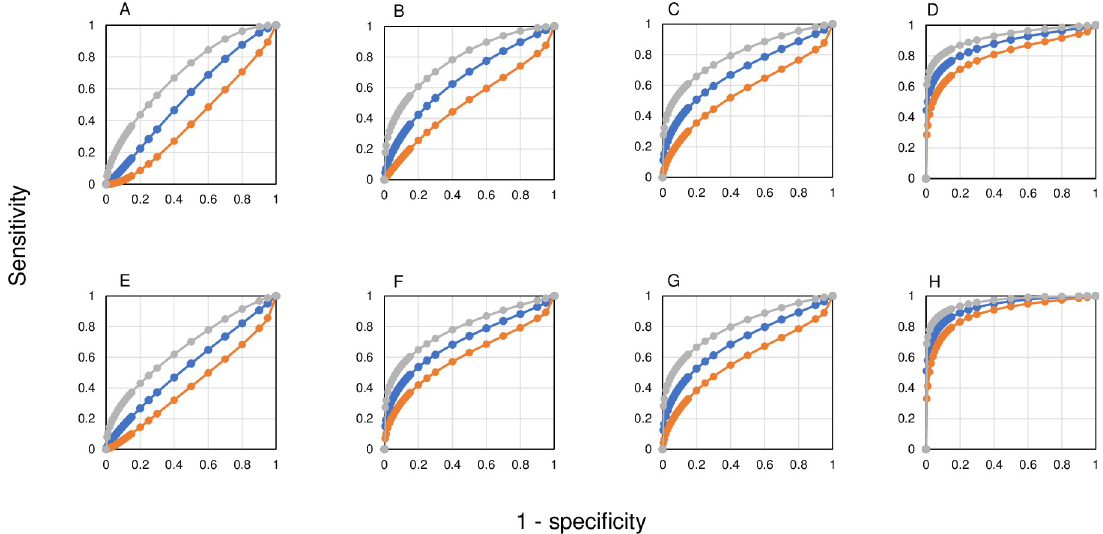
Fig 4. Receiver-operating characteristics for MLRs by sex and patient group. Females are represented in the upper line ( A , B , C and D ) and males in the lower line ( E , F , G and H ). A and E compare notified cases, TB and denotified. B and F compare TB found on screening (active case-finding) with screened LTBI, excluding contacts. C and G compare S+PTB found at screening with LTBI in contacts of S +PTB cases. D and H compare all S+PTB (active and passive case-finding) with LTBI in contacts of S+PTB cases. See Table 5 for values of the area under the curve (AUC) and optimal diagnostic indices.